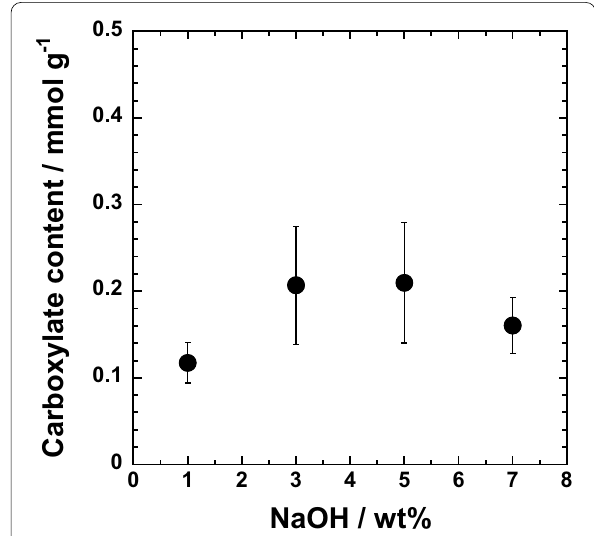
Fig. 4 Carboxylate content in CM-CNFs estimated by conductivity titration. Carboxymethylation was performed after